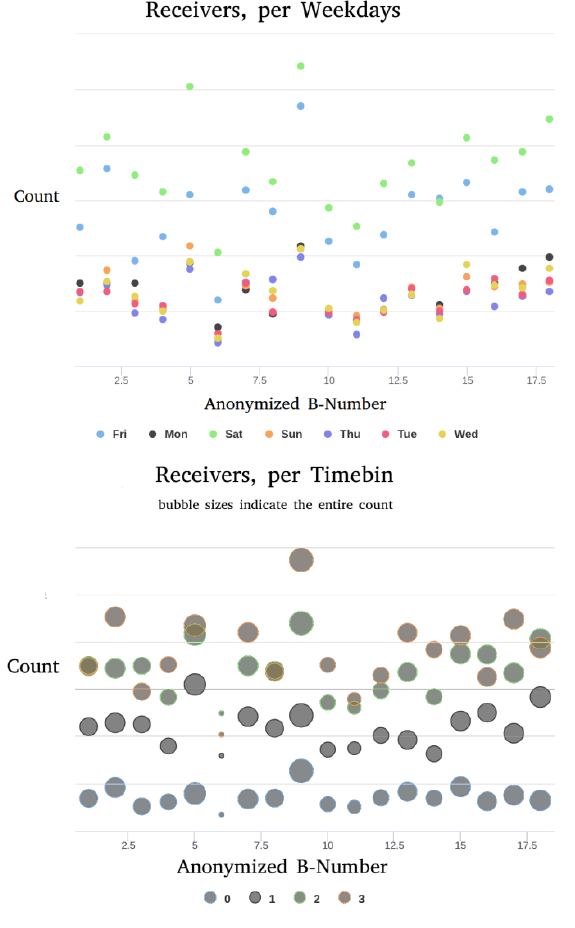
Figure 2. Number of received messages versus users' anonymized A-numbers.